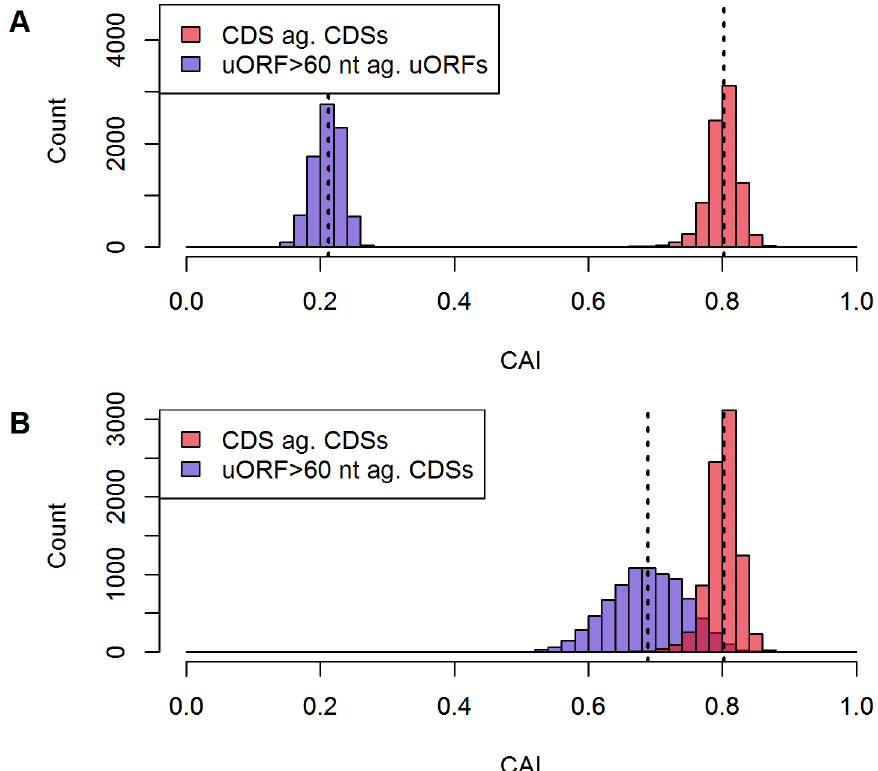
Fig 6. Distribution of CAI throughout uORFs and CDSs. ( A ) uORFs against uORF background achieve significantly lower CAIs compared to CDSs. Dashed lines represent the median CAI values for both sets (0.21 and 0.80 for uORFs and CDSs, respectively). There is not a single sequence overlapping the other subset’s CAI values, when calculated against the inherent subset. ( B ) Calculating the CAI for uORFs against CDS background results in an overlap of both subset’s CAI range. The difference of CAIs in both sets remains significant (median CAI 0.69 and 0.80, non-paired Wilcoxon test, p < 0.05). (n CDS = 8,345, n uORF =